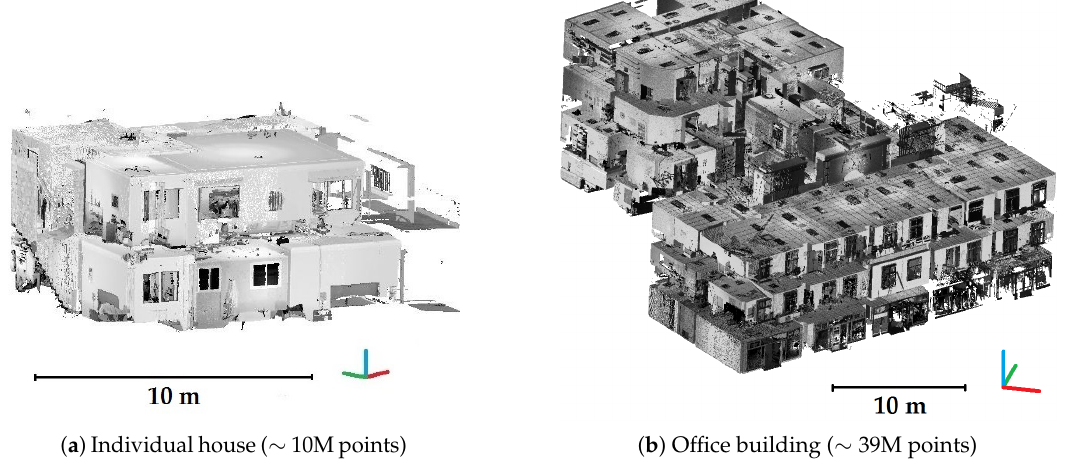
Figure 11. Datasets used for the assessment of the approach: indoor point clouds resampled at 1